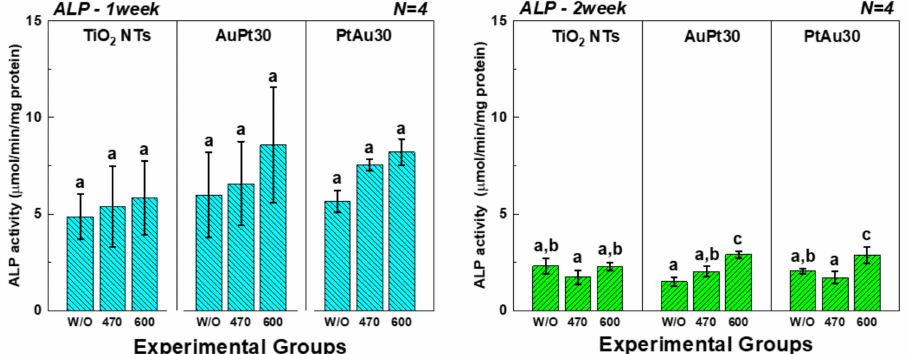
Figure 7. The ALP activity of the hMSCs cultured on Au and Pt multi-coated TiO 2 nanotubes. In the graph, W/O, 470, and 600 designate no irradiation, 470 nm irradiation, and 600 nm irradiation, respectively. Moreover, in each graph, the values of experimental groups with the same lowercase letter (a, b, or c) are not statistically different as determined by one-way ANOVA at α =